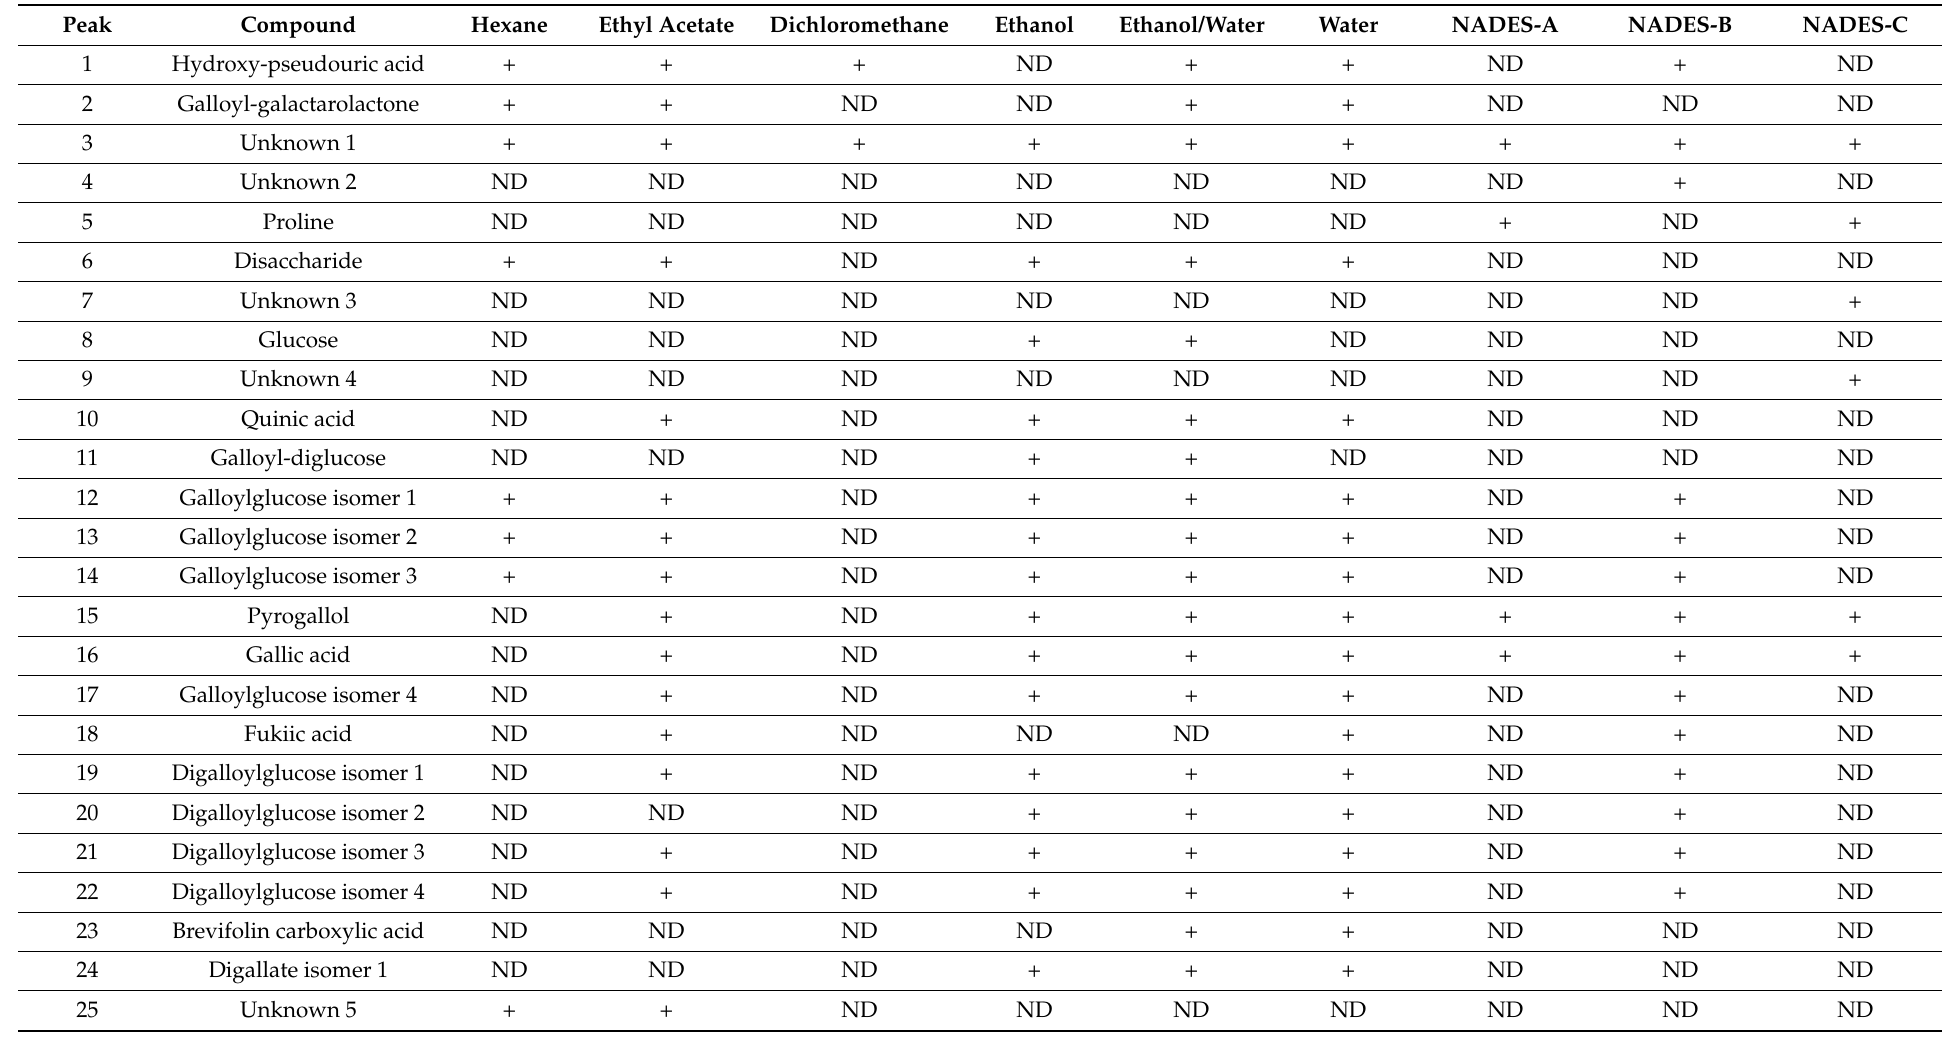
Table 1. Chemical characterisation of the tested